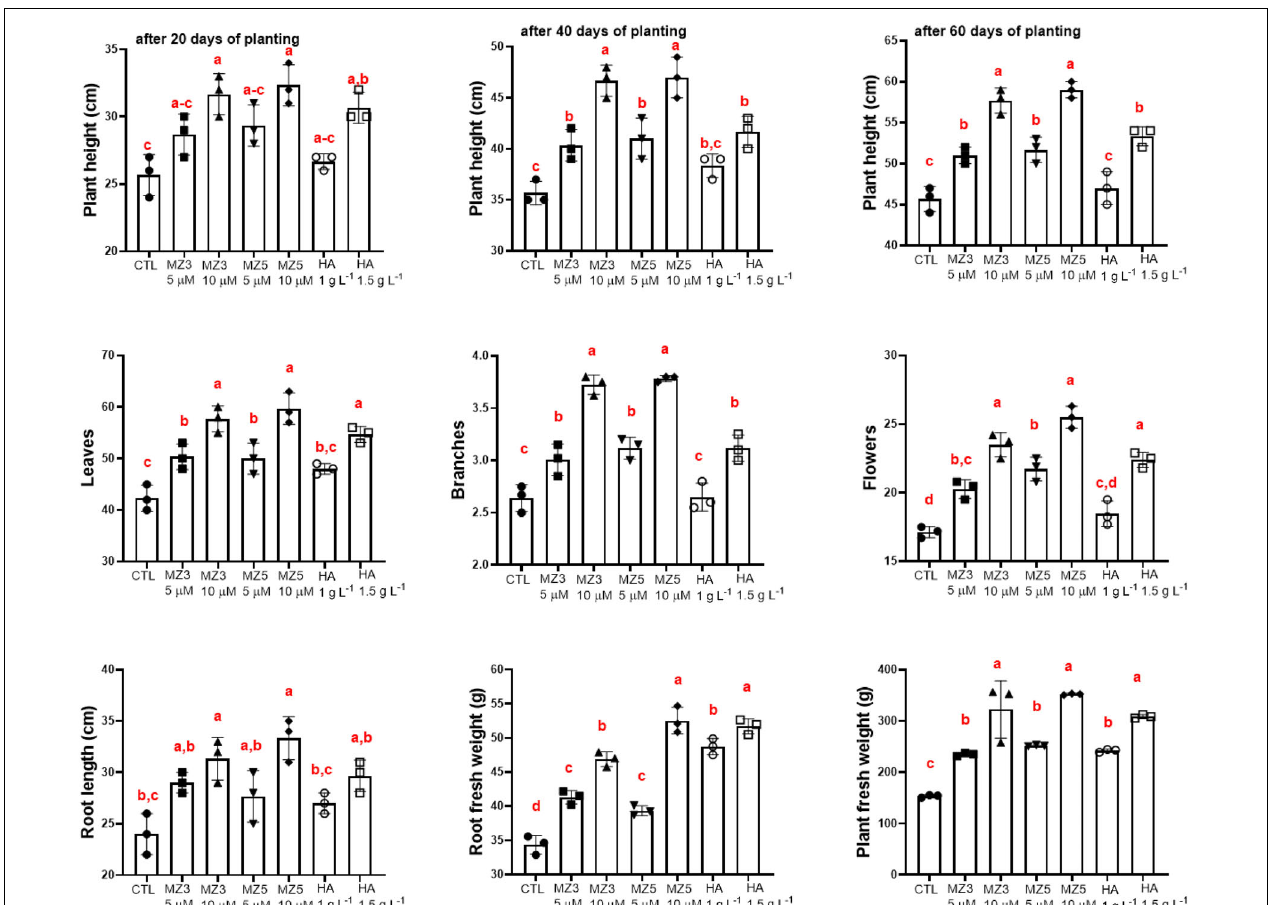
FIGURE 3 | Plant phenotypical evaluation of mimics of zaxinone (MiZax) effect on green pepper from the field of the King Abdulaziz University (KAU), performed in 2020. Each data point represents the average from 15 plants of three plots ( n = 3). Data represent mean ± SD . Statistical analysis was performed using one-way ANOVA and the Tukey’s post hoc test. Different letters denote significant differences ( p < 0.05). Symbols ( • , CTL; (cid:4) , 5 µ M MZ3; (cid:78) , 10 µ M MZ3; (cid:72) , 5 µ M MZ5; (cid:7) , 10 µ M MZ5;